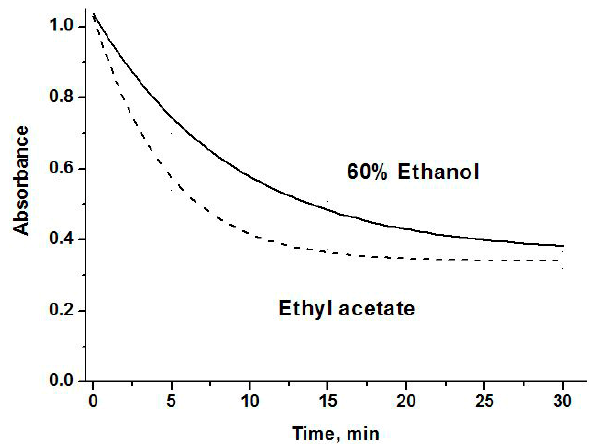
Figure 1. The kinetic curves of scavenged 1,1-diphenyl-2-picryl-hydrazyl (DPPH) radicals by the extracts of lingonberry fruits.